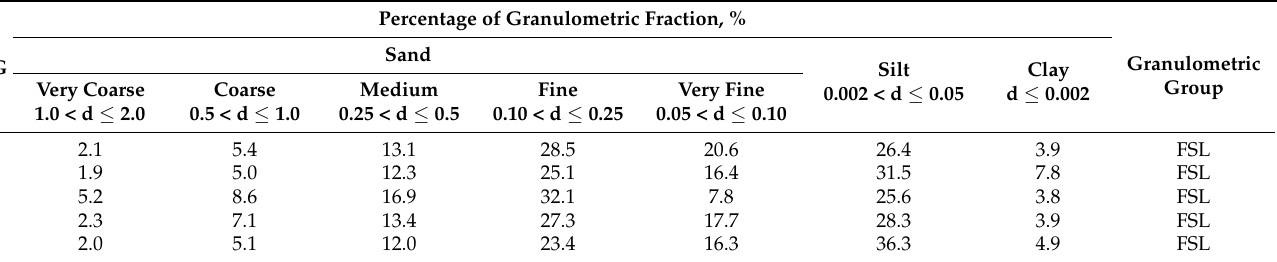
Table 2. Exemplary percentages of granulometric fractions in the cultivated